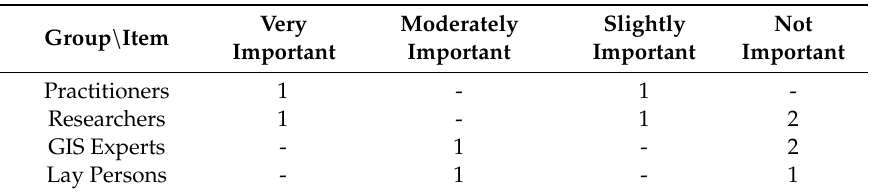
Table 2. Tracking individual